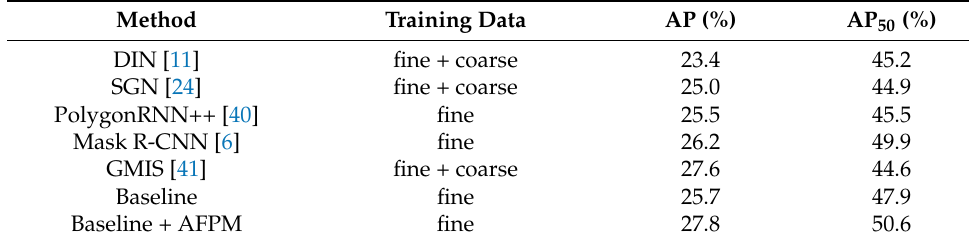
Table 6. Comparison of instance segmentation results on the Cityscapes test set.